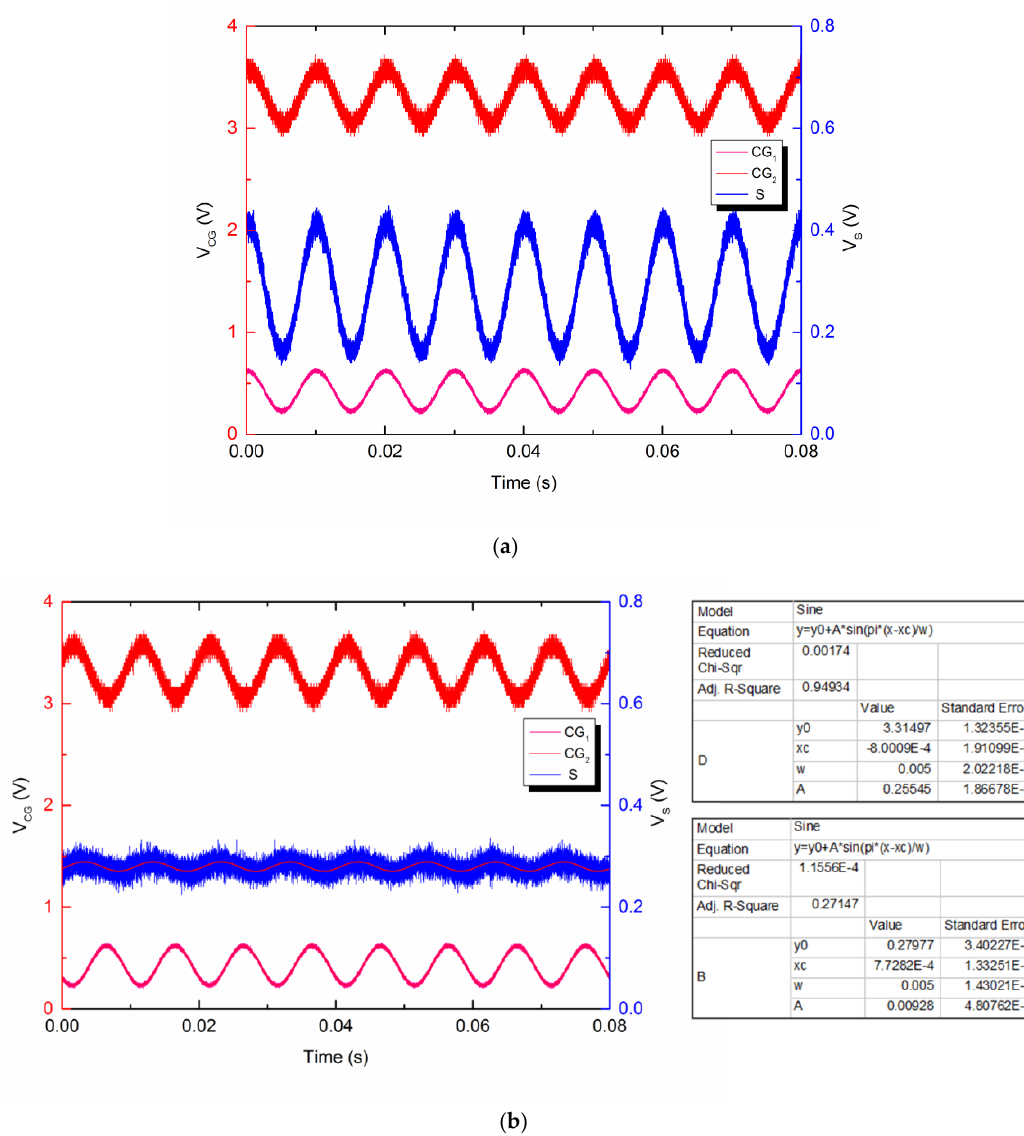
Figure 11. The measured voltage as a function of time, where the pink line is the signal on control gate 𝐶𝐺 1 , the red line is the signal on control gate 𝐶𝐺 2 , the blue line is the output signal 𝑉 𝑆 , and the input interference on control gate 𝐶𝐺 2 and the output signal are fitted by a sinusoidal function respectively with the parameters given in the insets. ( a ) Without active noise control, the output signal 𝑉 𝑆 follows the superposition of signals 𝑉 𝐶𝐺 and 𝑉 𝐶𝐺 as calculated. ( b ) With active noise control, the output signal V S is 9 mV and has a 29 dB attenuation for the input interference of 255 mV.